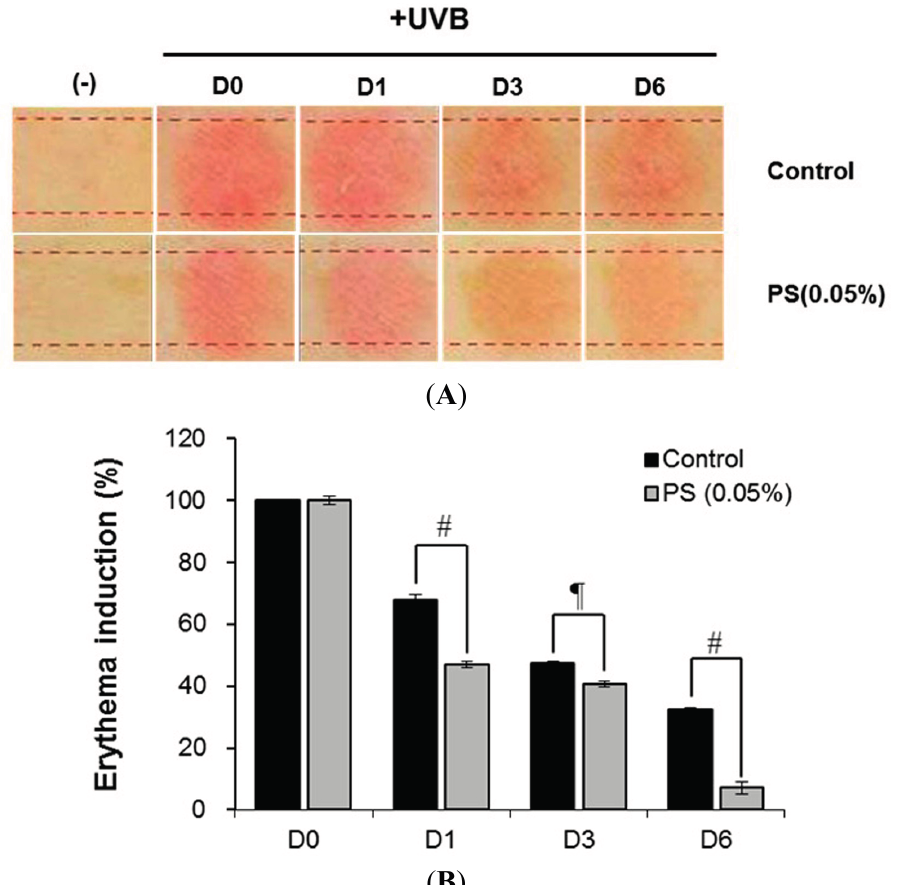
Figure 8. Skin recovery effects of phloretin 3',3-disulfonate were evaluated in human studies. Test areas on the forearms of 18 healthy subjects were treated with phloretin 3',3-disulfonate or the vehicle for 30 min. Subsequently, the test areas were irradiated with 1.5-fold the MED and the induced erythema was measured photometrically at the first visit (base line: before UV irradiation), 0 (after UV irradiation), 1, 3 and 6 days after application of phloretin 3',3-disulfonate . ( A ) Digital images and ( B ) induction percentage of erythema on forearm following 6 consecutive days application of phloretin 3',3-disulfonate. Data are presented as the mean ± standard deviation ( N = 18), ¶ p < 0.05 compared with the UVB-treated group, # p < 0.01 compared with the UVB-treated group; PS: Phloretin